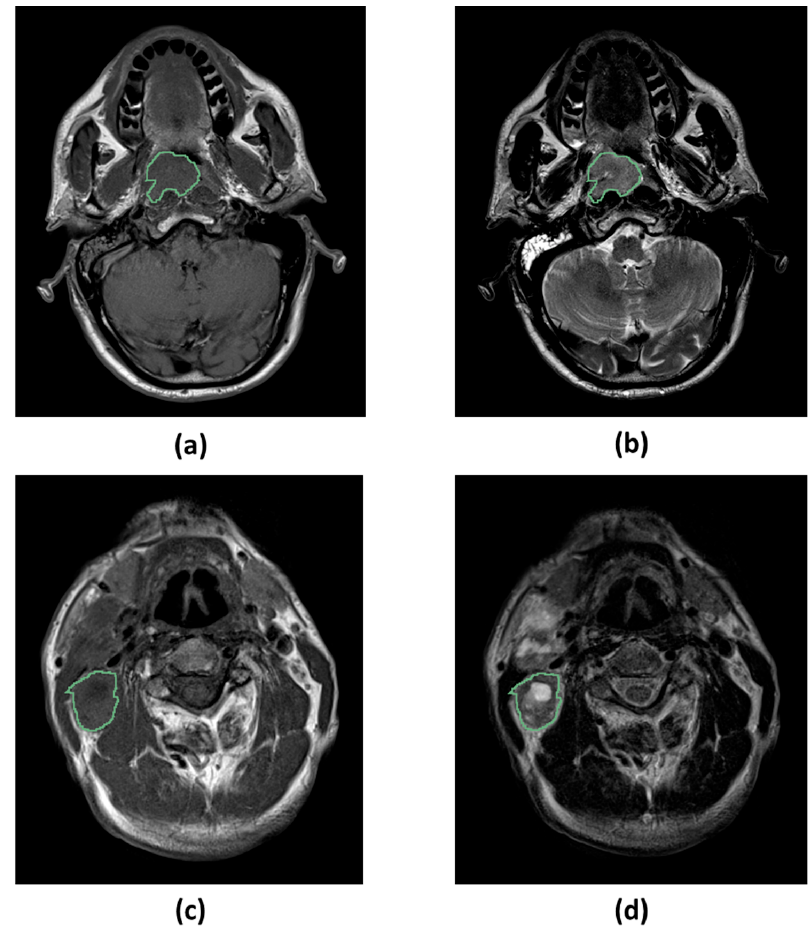
Figure 6. Types of magnetic resonance images and regions of interest used for the study. ( a ) Primary tumor on T1-weighted image. ( b ) Primary tumor on T2-weighted image. ( c ) Largest affected lymph node on T1-weighted image. ( d ) Largest affected lymph node on T2-weighted image. All the images represent 2D slices from a 3D region of interest.